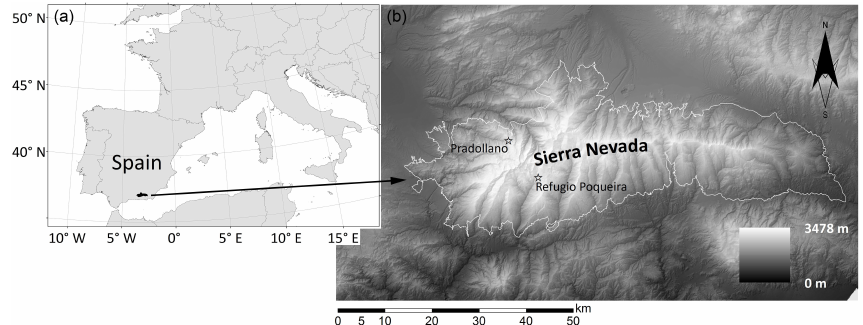
Figure 1. Location of Sierra Nevada in southern Spain (left) and digital elevation model (m) of the study area (right). The enlargement shows the limits of the Sierra Nevada National Park (white line) and the location of the Refugio Poqueira monitoring site (2500ma.s.l.) and the town of Pradollano